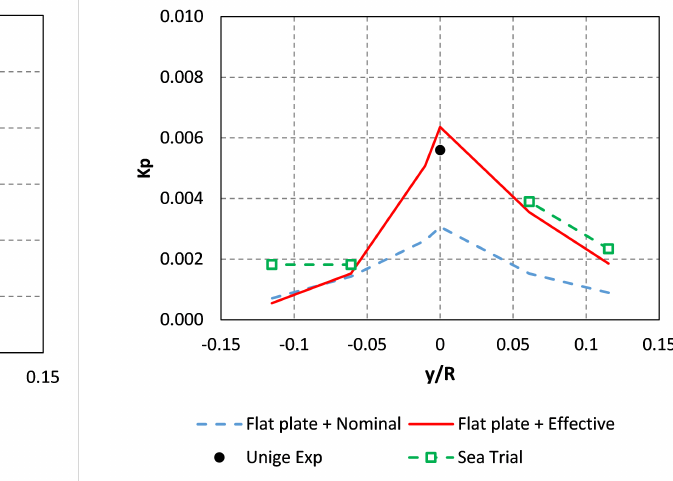
Figure A.6: Fourth harmonic values in correspondence to different points on the hull stern. Influence of the longitudinal position with the full-scale Nominal inflow wake.